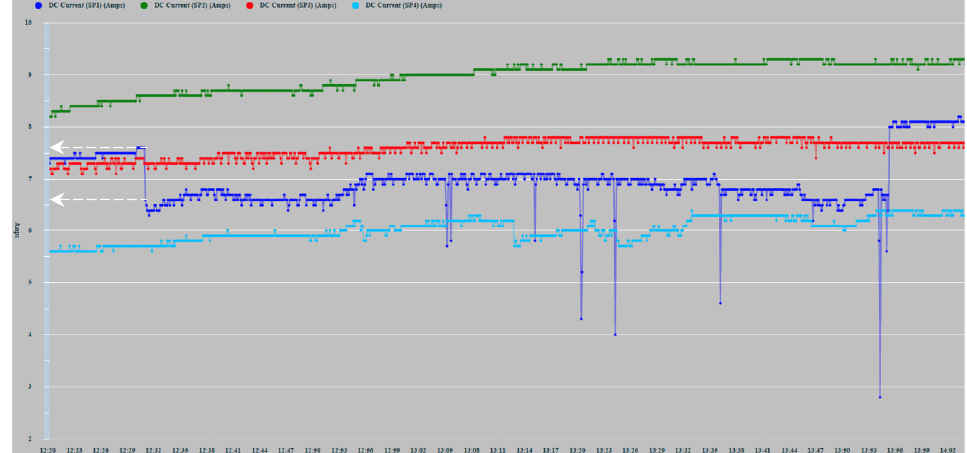
Figure 17. Effect of induced shading on SP1 from 12:30 to 13:55.